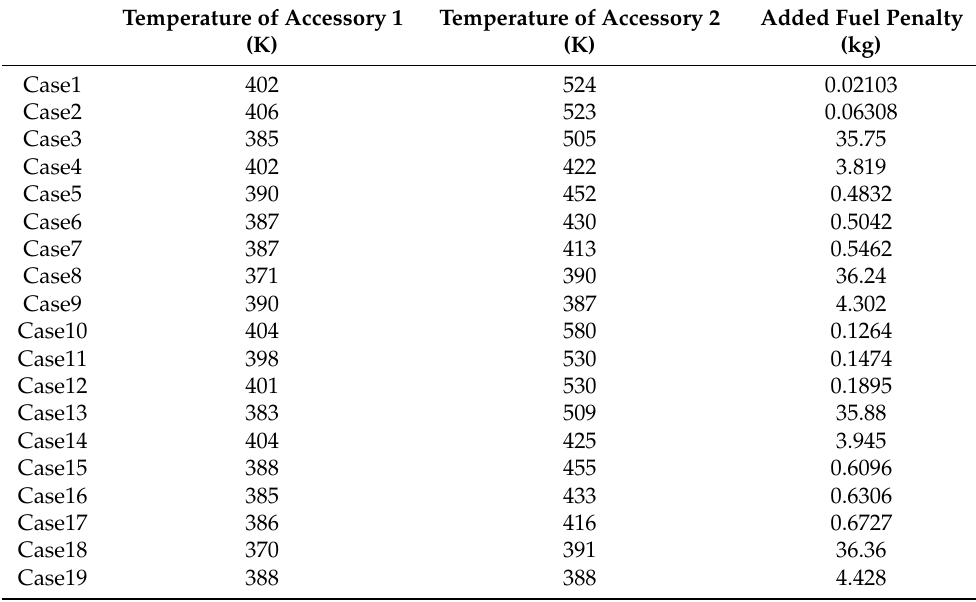
Table 5. Integrated thermal protection calculation results and